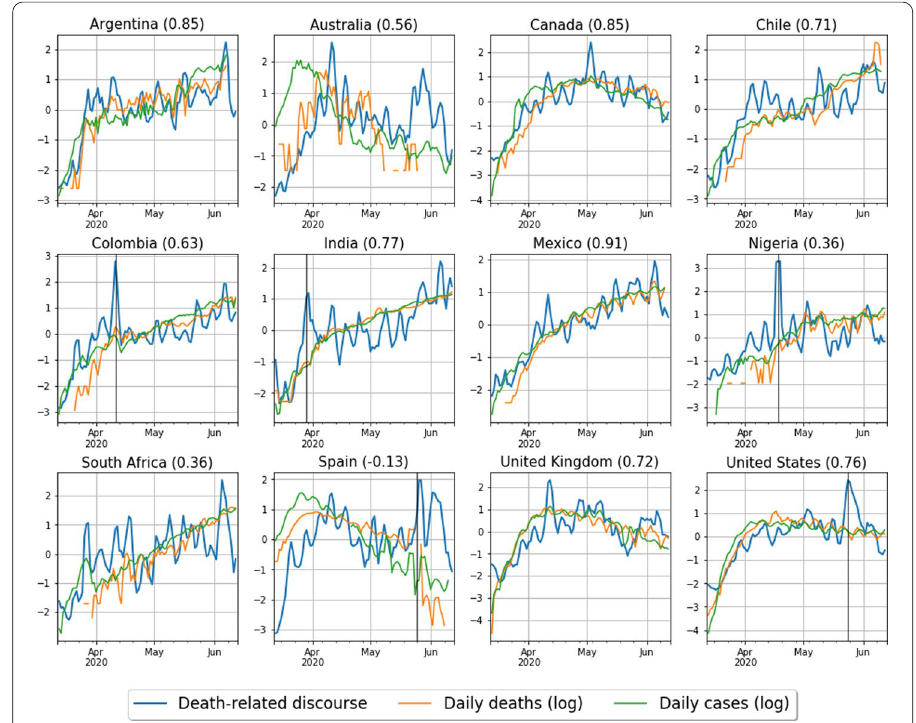
Fig. 6 Panel time series for p Death i ( t ) (blue), the logarithm of the daily deaths (orange), and the logarithm of the daily cases (green). Each panel presents a different country, with the country name provided in the subplot title. The correlation between p Death i ( t ) and the national daily death rate is given in parentheses for each country. Data is smoothed with a 3-day moving average and standardized with their z -score to make them visually comparable. Black vertical lines represent peaks in the death discourse caused by exogenous events not related to psychophysical numbing (see “Appendix 2” for details) which we remove from the time